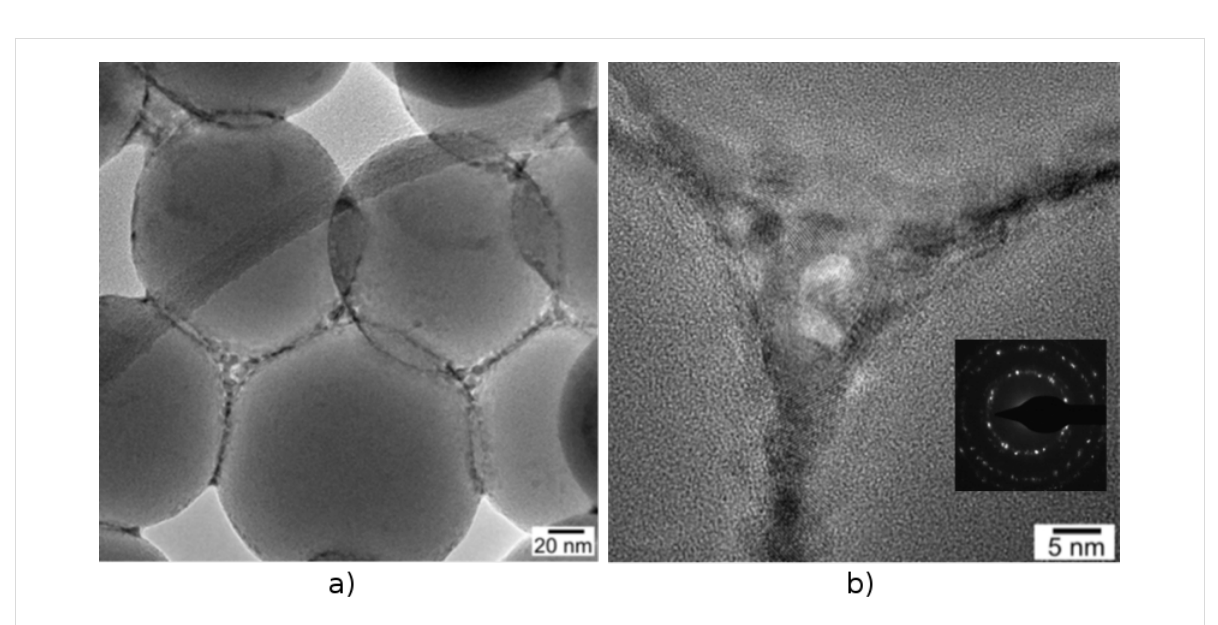
Figure 3: TEM images displaying the particulate character of the ternary oxide microtubes obtained after calcination at 750 °C (see Figure 2 for SEM). a) The spherical and amorphous Stoeber particles are ca. 150 ± 10 nm in diameter). b): HRTEM and SAED pattern of the crystalline oxidic ceria/zirconia material deposited in the interstices between the spherical amorphous silica particles during the spray-coating process. Inset in b): SAED pattern of the poly-crystalline, oxidic ceria/zirconia material deposited in the interstices between the SiO 2 particles.